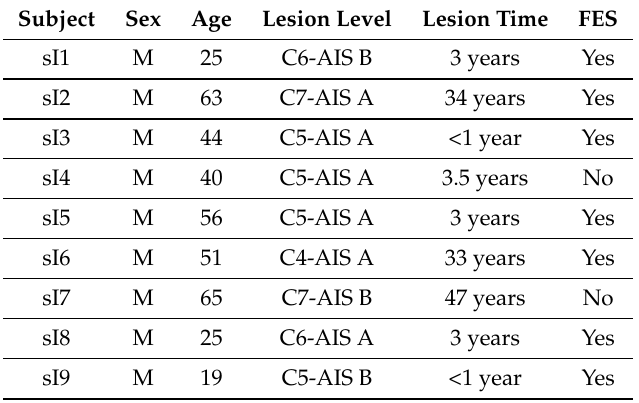
Table 2. Subject characteristics for the inertial sensors (IMU)